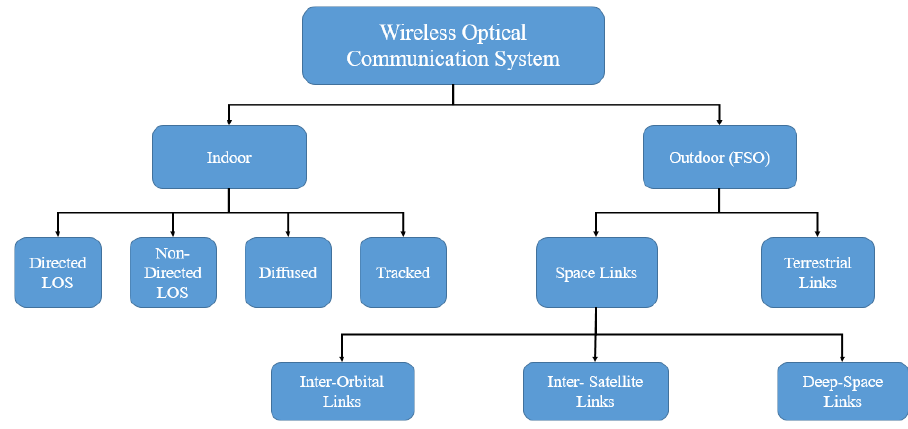
Figure 1. Wireless Optical Communications Classifications. Data from Ref. [5].